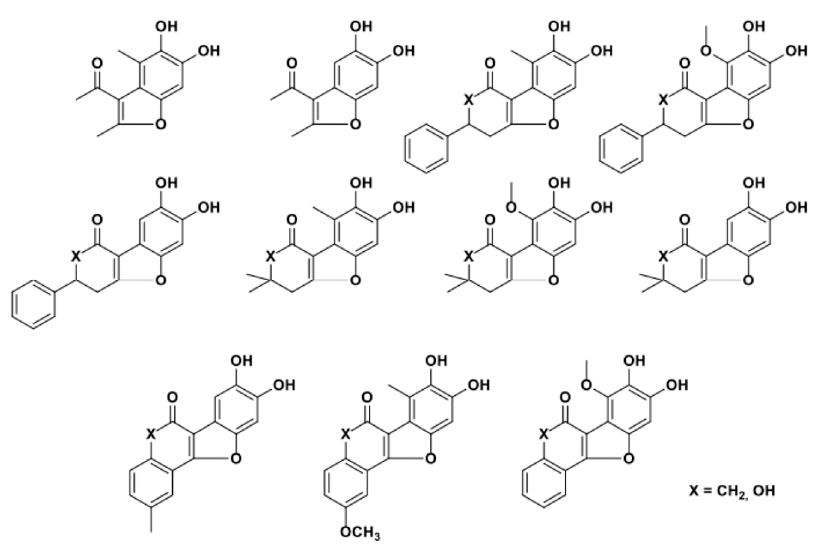
25 of 34 25 of 34